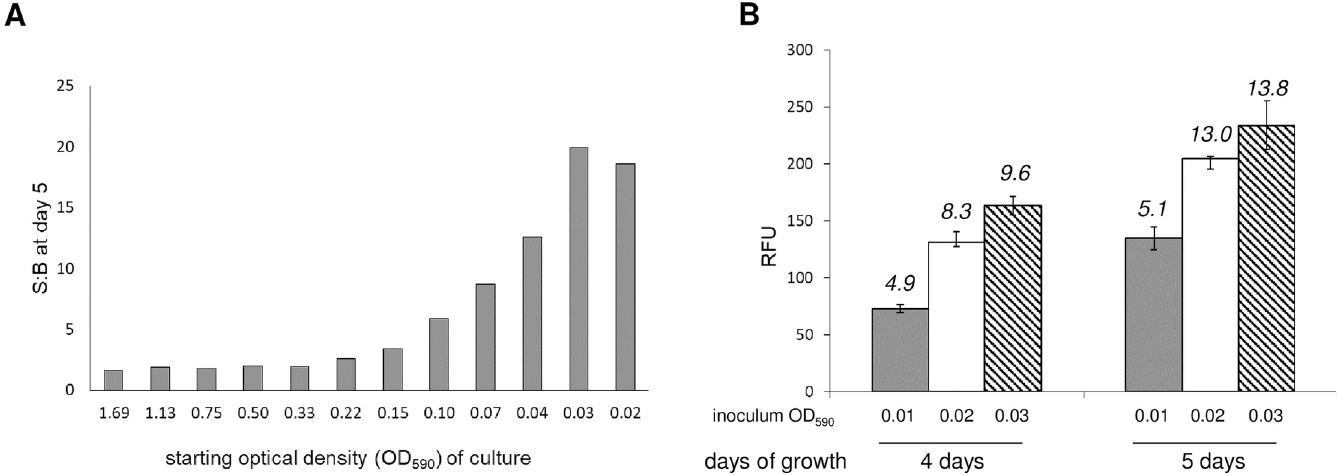
Fig 2. Optimization of growth conditions. (A) Serial dilutions of CHEAM3 were plated in triplicate in a 384 well plate and measured for fluorescence before and after five days of incubation. The signal to background (S:B) for each inoculum was calculated (average signal D0 � average signal D5) to identify the greatest amplitude to measure growth of cells over the course of 5 days. (B) 320 experimental wells of a 384 well plate were inoculated with CHEAM3 diluted to a starting OD 590 of 0.01, 0.02 or 0.03. Plates were read on D4 and D5. The average fluorescence for each condition (n = 320) was plotted, with error bars indicating the standard deviation. The calculated signal to background (S:B) is shown above each